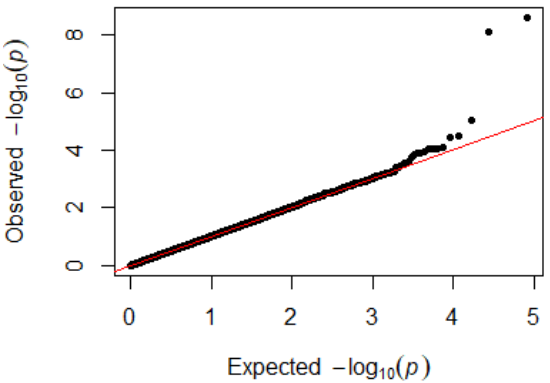
Figure 2. Quantile–quantile plots of p -values for heterophils. The x-axis is the expected − log10 p -value and the y-axis is the observed − log10 p -value.